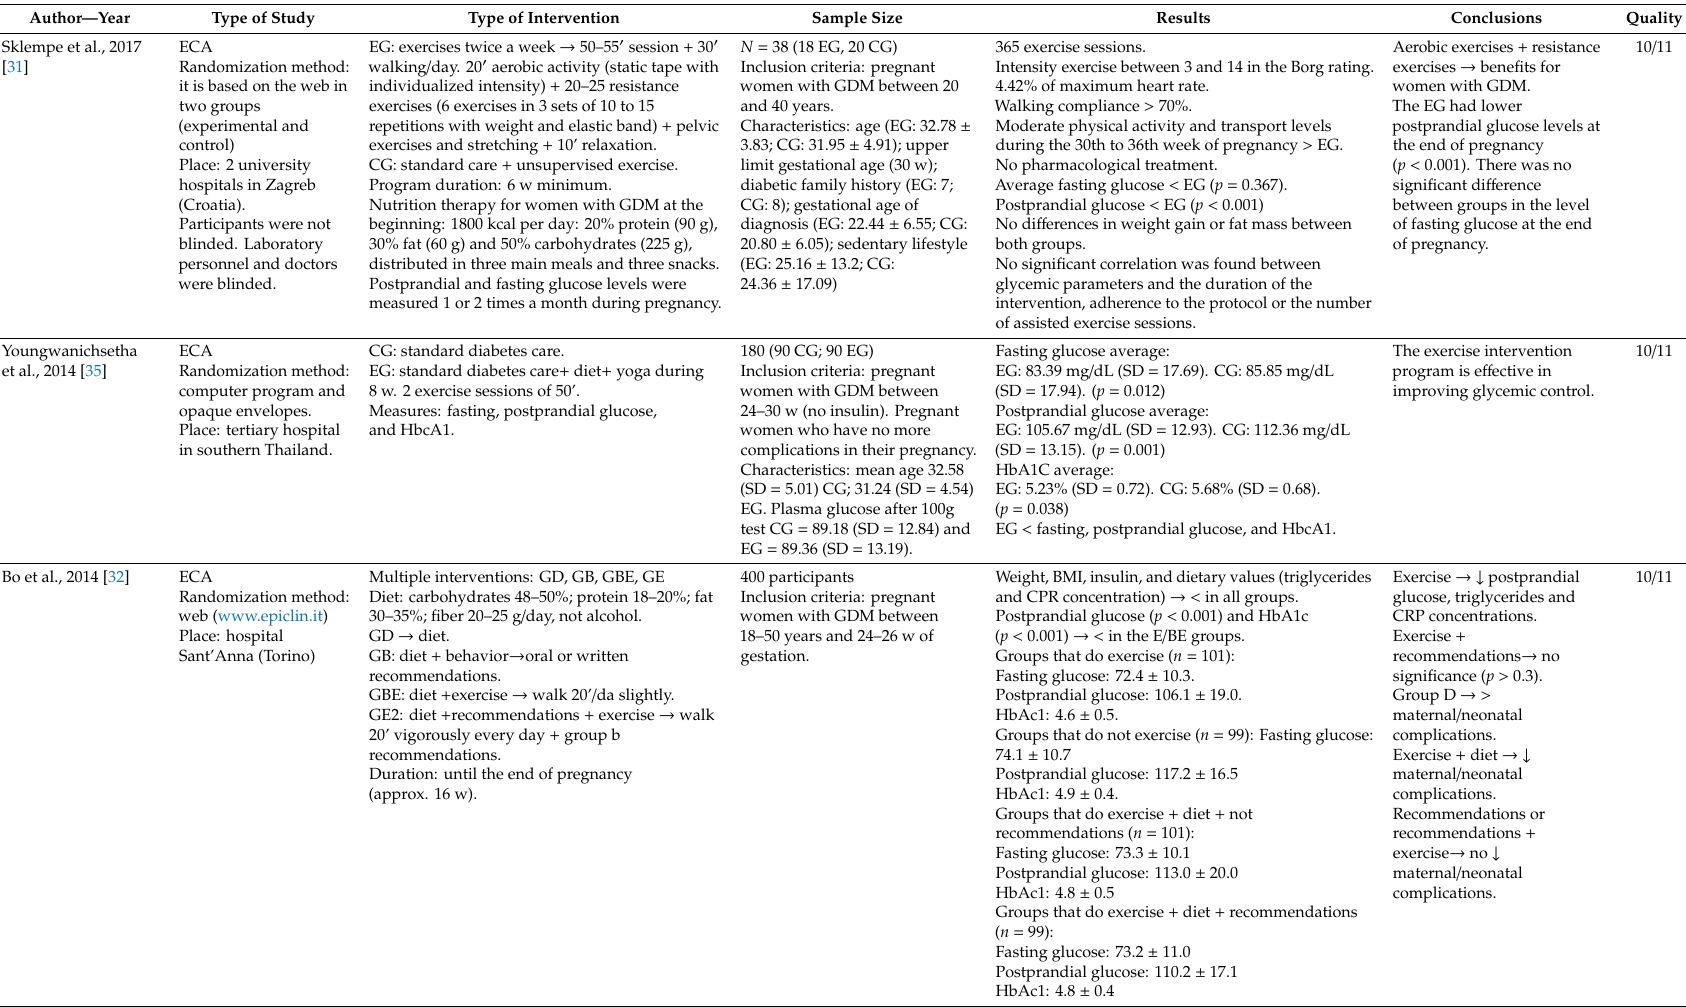
Table 2. Description of the type of study, intervention, sample, results, conclusions, and year of the selected